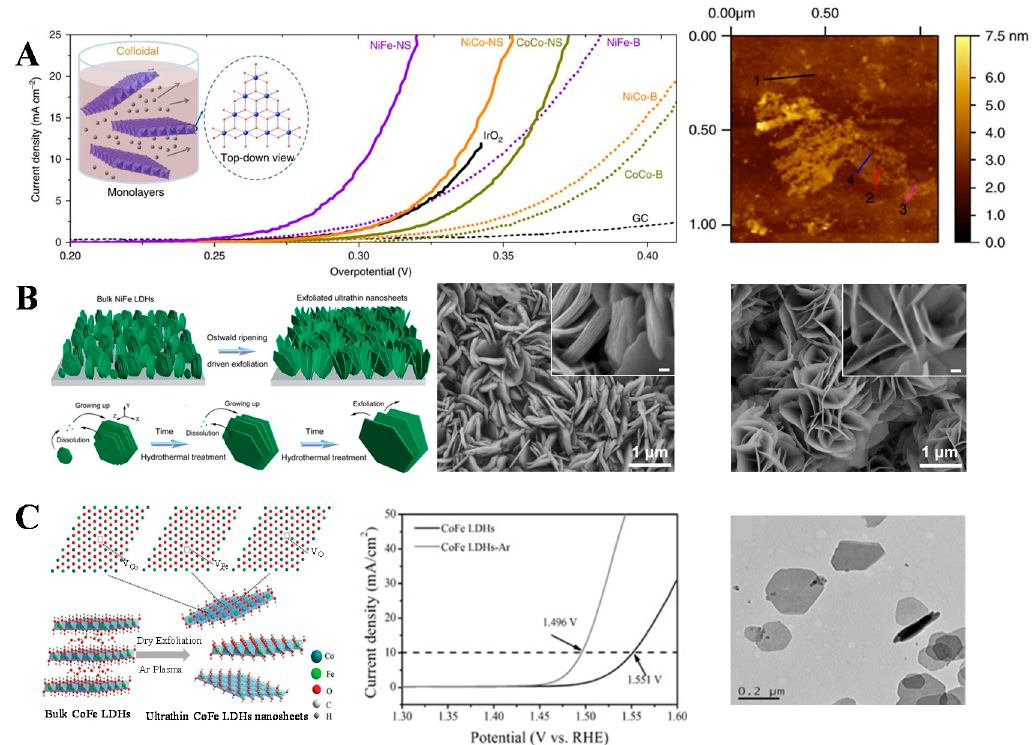
Figure 9. ( A ) Schematic representation of materials structures, the corresponding polarization curves at 1600 rpm in 1 M KOH and the AFM image of exfoliated single-layer nanosheets of NiCo LDH [160]. Copyright © 2014 Macmillan Publishers Limited. ( B ) Schematic illustration for pristine bulk NiFe-LDHs transformed to exfoliated ultrathin nanosheets via the ORDE process, and the SEM characterizations of the pristine bulk (left) and exfoliated NiFe LDHs (right) [164]. Copyright © 2018 American Chemical Society. ( C ) CoFe-LDH nanosheets by Ar plasma exfoliation, the corresponding OER performance at 1600 rpm in 1 M KOH and the TEM image of the ultrathin CoFe LDHs-Ar nanosheets [165]. Copyright © 2017 Wiley-VCH Verlag GmbH & Co. KGaA,